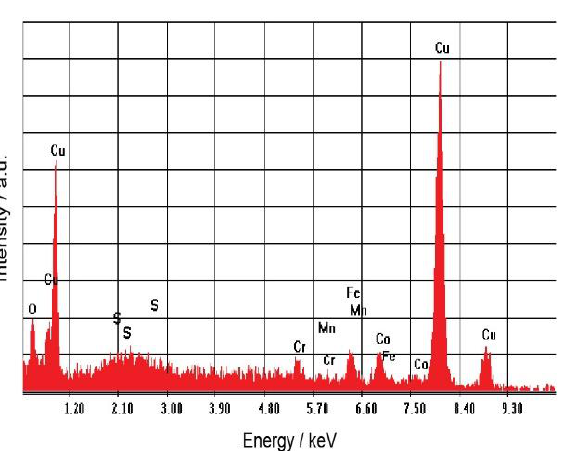
Figure 16. SEM morphology of the Co 0.12 Cr 0.55 Fe 0.11 Mn 0.1 Ni 0.12 thin film, sample 3 (corroded): ( a ) ×1000; ( b ) ×10,000.